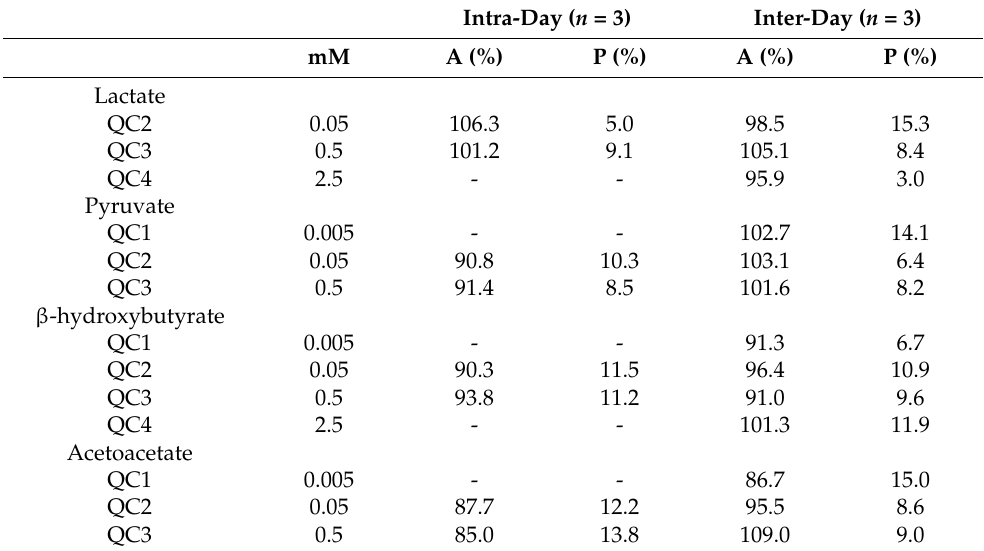
Table 4. Intra-day and inter-day precision expressed as relative standard deviation and accuracy values of quality. A: accuracy; P: precision; QC: quality